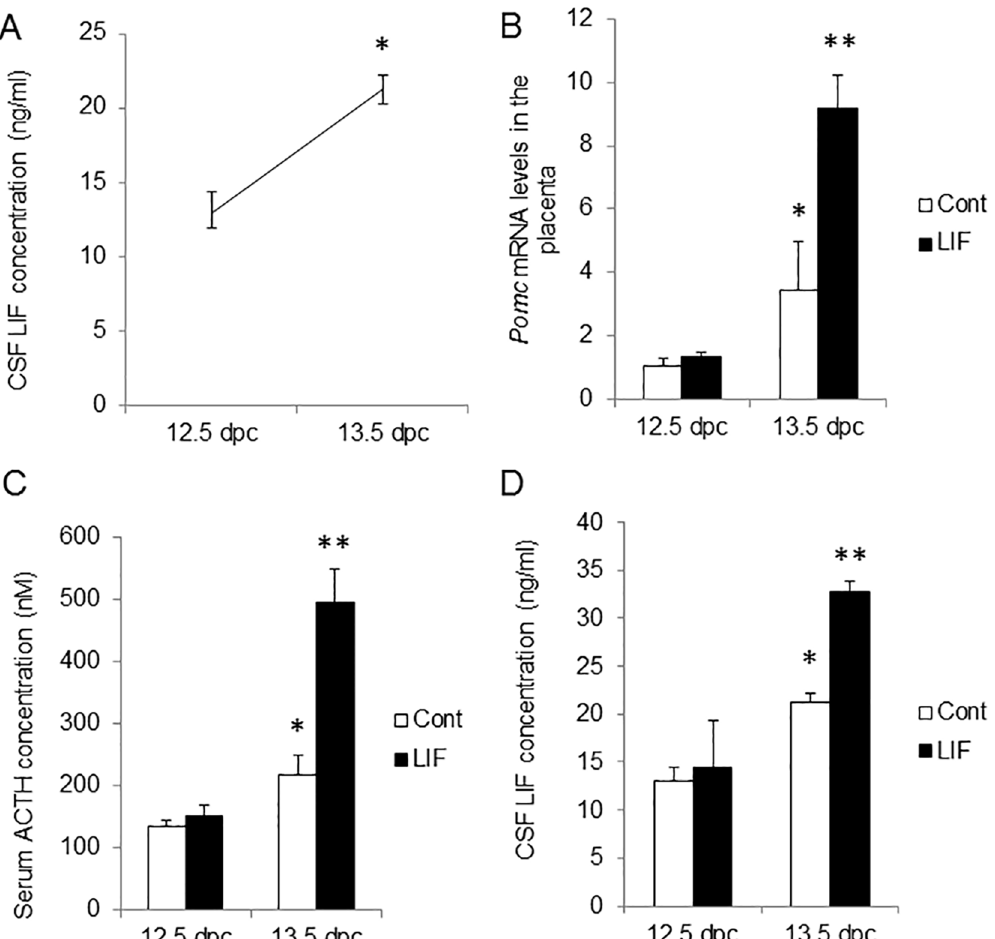
Fig 1. Response of leukemia inhibitory factor (LIF) – adrenocorticotropic hormone (ACTH) – LIF signaling to maternal LIF stimulation in mice. (A) Chronological change of LIF levels in fetal cerebrospinal fluid (CSF). (B) Pomc expression levels in the placenta. (C) ACTH level in fetal serum. (D) LIF level in fetal CSF. Reactivity to maternal LIF stimulation in placenta and fetus were examined at 3 h after the injection at 12.5 and 13.5 days post-coitum (dpc). Mouse recombinanat LIF (rLIF) was administered to dams at 5 μ g/kg body weight. * , p < 0.05 vs. control at 12.5 dpc. ** , p < 0.05 versus control at 13.5 dpc. Number of dams = 3 or 4 in each group. Error bars ,